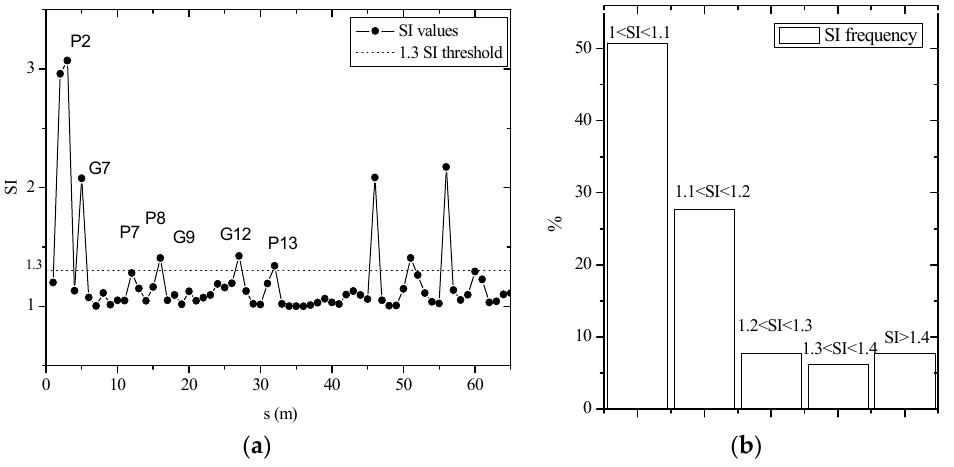
Figure 6. ( a ) Sinuosity index along the centerline of the Reyran riverbed from upstream to downstream (distance 150 m); and ( b ) sinuosity index frequency corresponding to the five classes: 1 < SI < 1.1; 1.1 < SI < 1.2; 1.2 < SI < 1.3; 1.3 < SI < 1.4; and SI > 1.4.